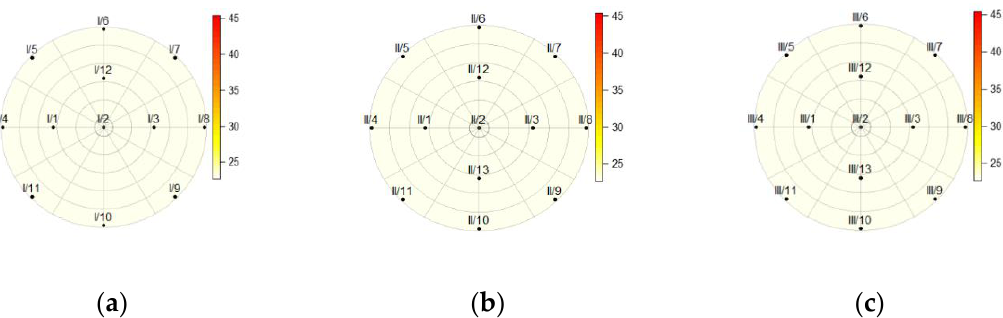
Figure 10. The temperature within the pillar at a height of ( a ) 150 mm; ( b ) 750 mm; ( c ) and 1350 mm before the heat source was turned on ( t = 0 h).